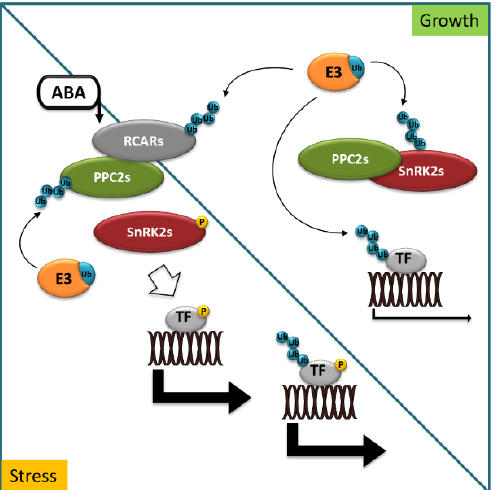
Figure 1. Abscisic acid (ABA) signaling in stress and growth. In growth-promoting conditions, ABA receptors (RCARs), protein kinases (SnRK2s) dephosphorylated by type 2C protein phosphatases (PP2Cs), and ABA-responsive transcription factors (TF) are marked for degradation with ubiquitin (Ub) by specific E3 ligases (E3). In stress conditions, ABA accumulates and binds to RCARs, allowing for interaction with PP2Cs to inhibit phosphatase activity. SnRK2s are released to phosphorylate and control the activity of downstream targets to trigger physiological responses. Blue circles indicate ubiquitination, yellow circles indicate phosphorylation events.